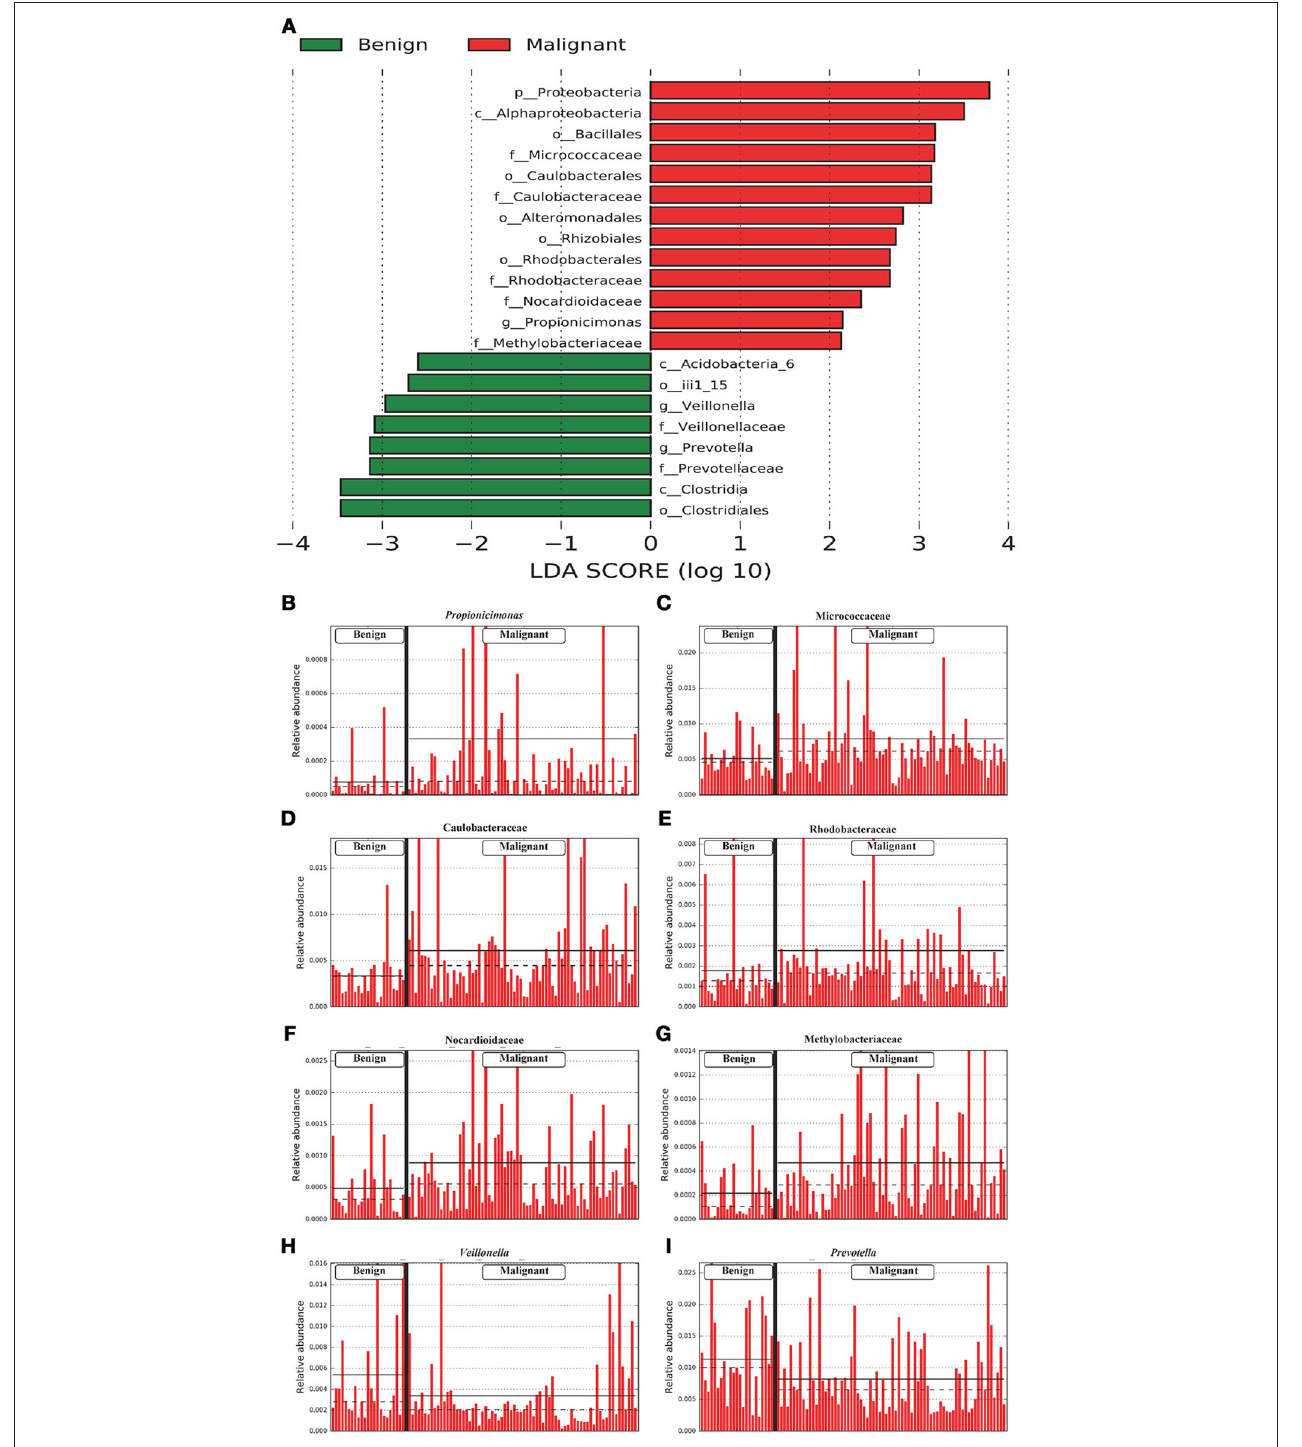
FIGURE 3 | LefSe identified the most differential microbiota between benign and malignant tumors. (A) Histogram of the LDA scores computed for abundance between benign and malignant. Benign are indicated with a negative LDA score, and malignant had a positive score. The LDA score also indicates the effective size and ranking of each differentially abundant taxon. (B–I). Barplots show the abundances of the three differential genera (B,H,I) and five differential families (C–G) between benign and malignant. Each bar represents a sample.